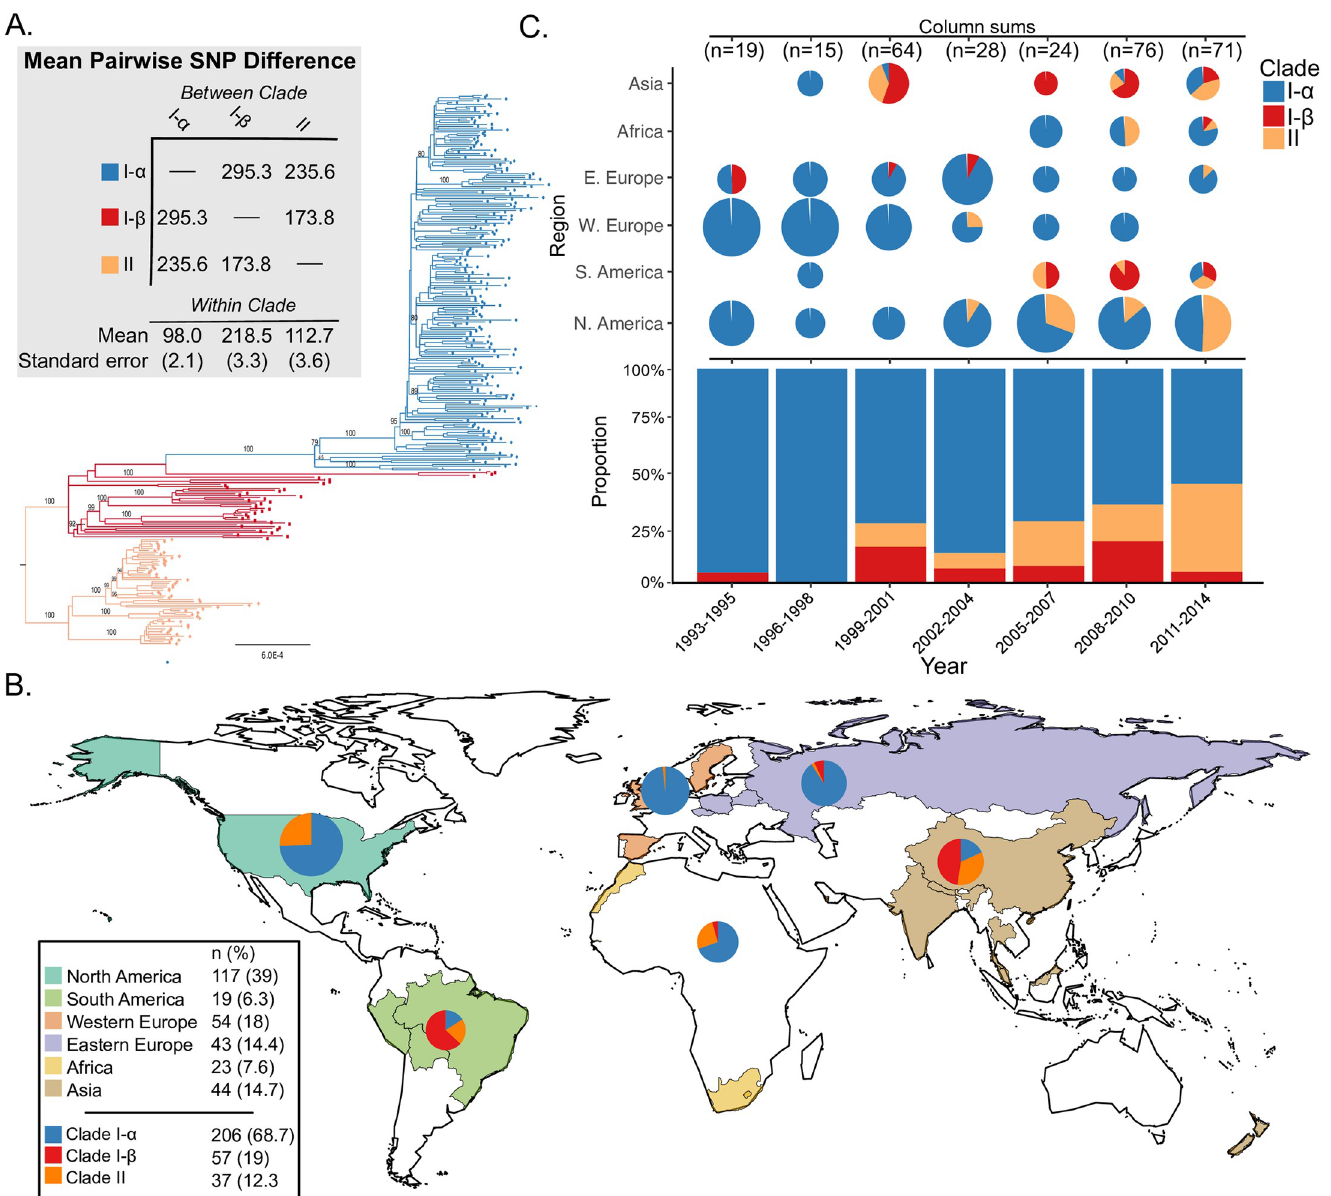
Fig 2. A) Rooted maximum likelihood phylogeny of S . pneumoniae serotype 3 CC180 isolates (n = 301) inferred from an alignment of 15,327 SNPs present in the core genome. Phylogeny was out-group rooted using strain AP200 (accession # CP002121) a serotype 11A, ST62 S . pneumoniae invasive isolate, which was found to be immediately basal to the CC180 clade in a global phylogeny of pneumococcal reference genomes and therefore represented the closest out-group. Bootstrap values from 100 replicates are labelled on major clades and epidemiologically relevant sub-clades. Additional values can be found in the supplemental phylogeny. Mean pairwise within- and between-clade SNP difference are presented in the grey shaded box with colors corresponding to the phylogeny. B.) World map illustrating sampled countries and regions with respective proportion of isolates belonging to Clade I- α , I- β , and II. Countries are colored according to region and pie charts represent the proportion of isolates belonging to major serotype 3 clades. The size of the pie chart is scaled to the proportion of strains sampled from each region. Mapping was performed using R package maps v3.3.0. C) Proportion of clade membership by three-year collection window. The proportion of clade membership by region over-time is displayed on the top of the figure. Pie charts are scaled by the number of isolates sampled from a geographic region by time window (i.e., column). The overall proportion of clades for each time window is presented on the bottom of the figure.